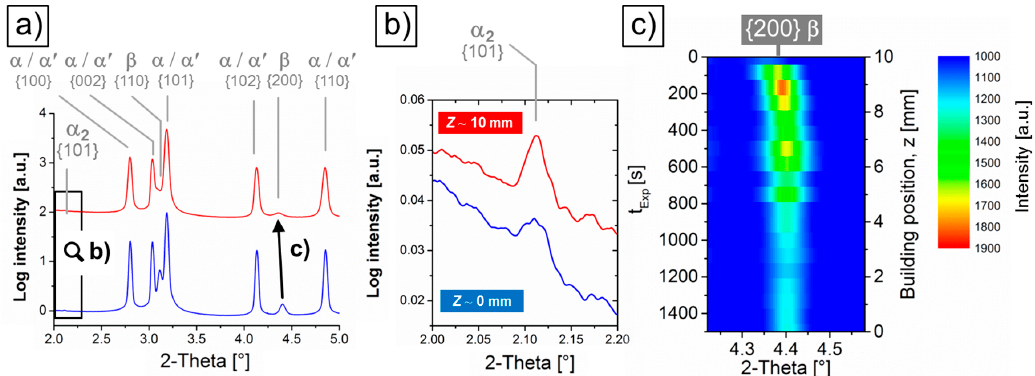
Figure 4. ( a ) Diffraction patterns (limited to a representative 2-Theta range) for the bottom and top building positions of the Ti-64 sample z = 0 mm (in blue) and z = 10 mm (in red), respectively. {hkl} reflections of α ’/ α and β are indicated; ( b ) Details of the 2-Theta region selected in ( a ) showing the presence of a low intensity {101} peak of α 2 -Ti 3 Al for both conditions; ( c ) Color-coded 2D intensity plot corresponding to the evolution of the {200} reflection of β (see relative 2-Theta position in ( a )) as a function of the building position z and exposure time t exp .